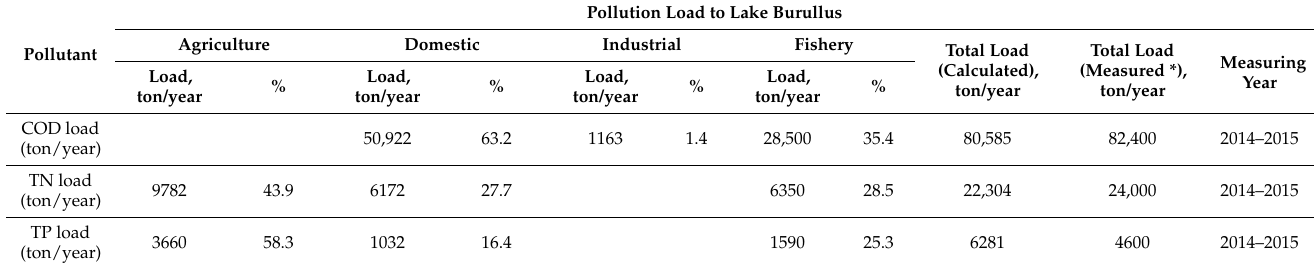
Table 8. Summary of pollution loads into Lake Burullus due to main pollution